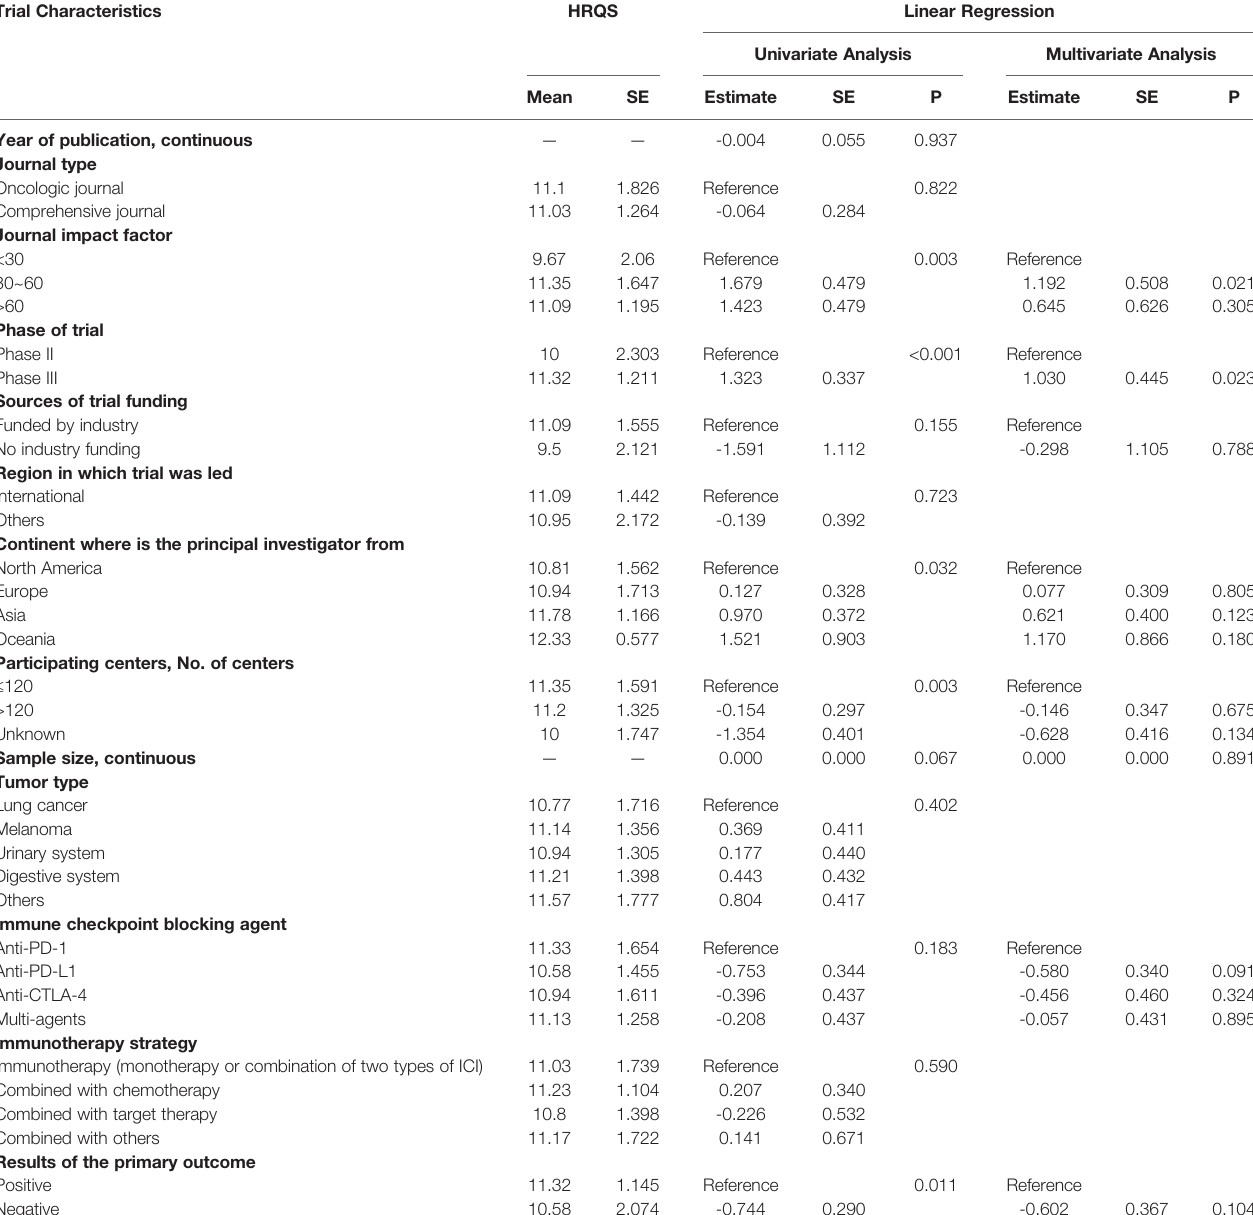
TABLE 5 | Trial Characteristics associated with harm reporting quality score (0-16